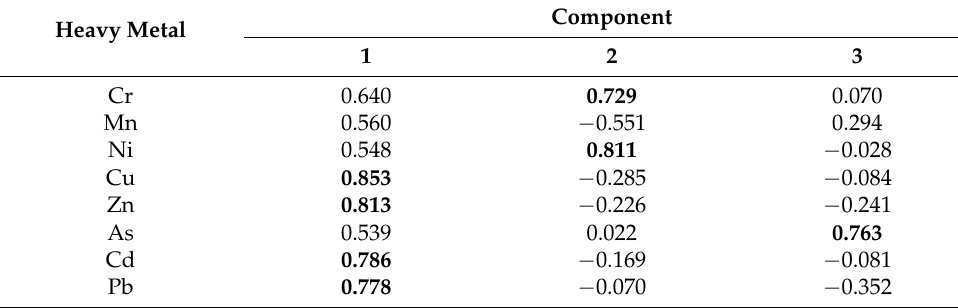
Table 8. Heavy metal factor load matrix for dust reduction.